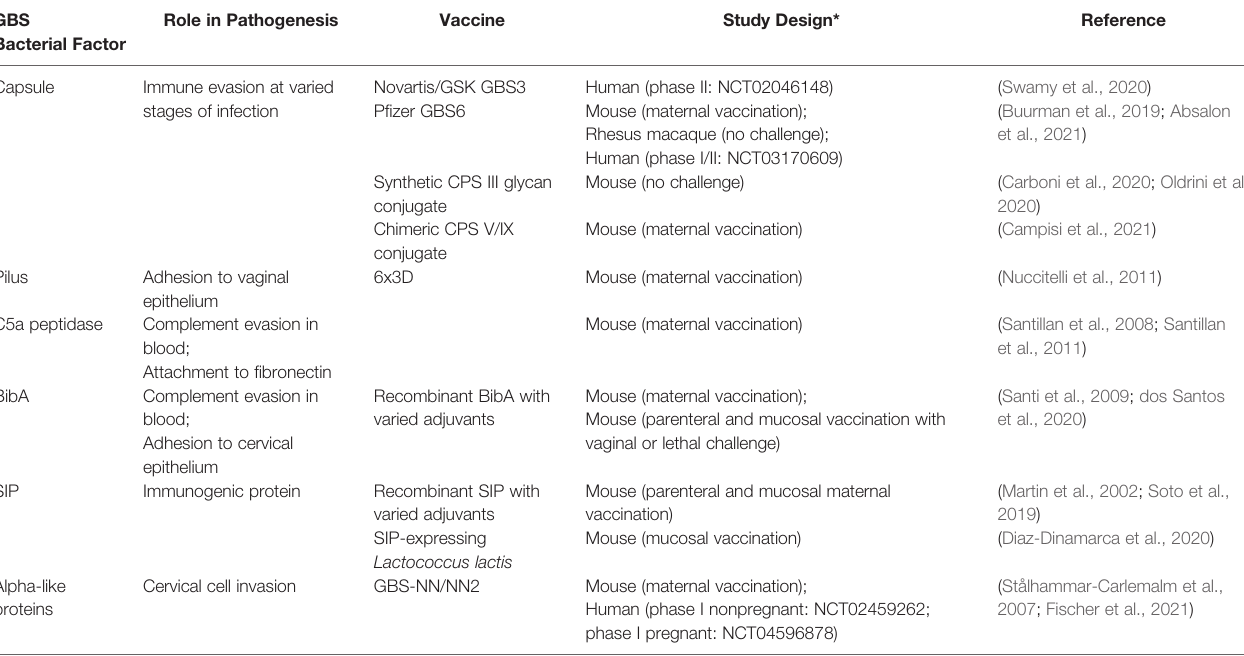
TABLE 1 | Novel in-pipeline vaccines that target GBS determinants of vaginal colonization and invasive